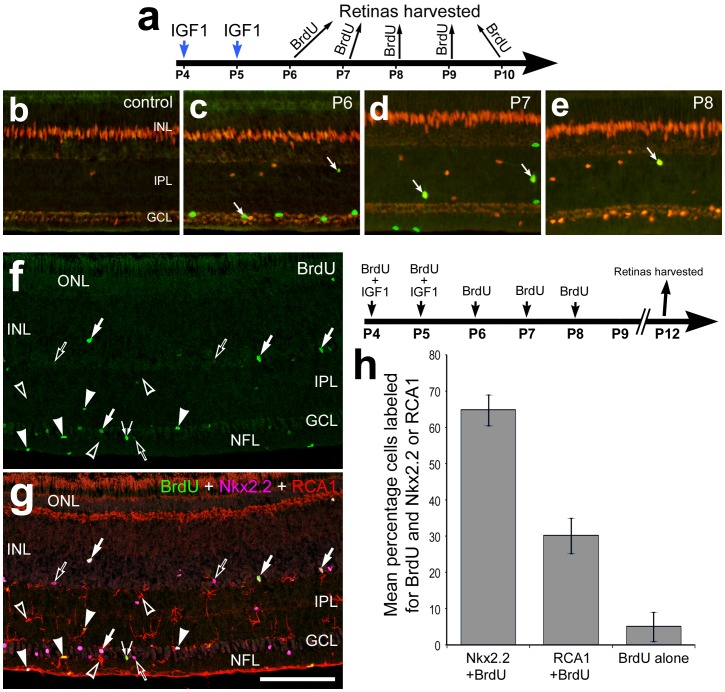
NIRG cells and microglia continue to proliferate for several days after exposure to IGF1.Vertical sections of the retina were labeled for Sox9 (red; b–e), BrdU (green; b–g), Nkx2.2 (magenta; g), and RCA1 (red; g). (a) Retinas were obtained from eyes that received injections of IGF1 at P4 and P5, and a single dose of BrdU was applied 4 hrs before harvesting at P6 (c), P7 (d), P8 (e), P9 and P10 (not shown). Alternatively, eyes received injections of IGF1+BrdU at P4 and P5, BrdU alone at P6, P7 and P8, and retinas harvested at P12 (f–h). Wide-field microscopy (b–e) and confocal microscopy were used to obtain images (f and g). The scale bar (50 µm) in panel g applies to b–g. Arrows indicate NIRG cells labeled for BrdU and Sox9 (b–e) or BrdU and Nkx2.2 (f and g), hollow arrows indicate Nkx2.2-positive NIRG cells that are BrdU-negative, arrow-heads indicate BrdU-labeled RCA1-positive microglia, hollow arrow-heads indicate BrdU-negative RCA1-positive microglia, and small double arrows indicate BrdU-labeled cells that are negative for RCA1 and Nkx2.2 (f and g). Abbreviations: ONL – outer nuclear layer, INL – inner nuclear layer, IPL – inner plexiform layer, GCL – ganglion cell layer.